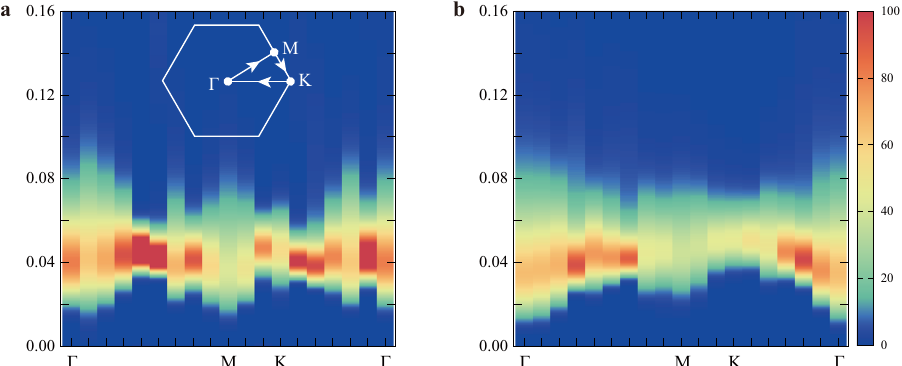
Fig. 4 Probing the vison gap. Vison-pair spectra obtained from the QMC dynamical density – density 〈 n i ( τ ) n j (0) 〉 (or h S z i ð τ Þ S z j ð 0 Þi in the spin language) correlation function and stochastic analytic continuation, plotted along the high symmetry path Γ -- M -- K -- Γ in the Brillouin zone. The horizontal axis is momentum, while the vertical one represents energy (frequency) (note the energy scale here is very low compared with, for example, the scale of the bare interaction which is V = 1). a At the XY* critical point ( t / V ) c = 0.070756 at boson fi lling 〈 n i 〉 = 1/2 with system size L = 18 and β = 500. b At the